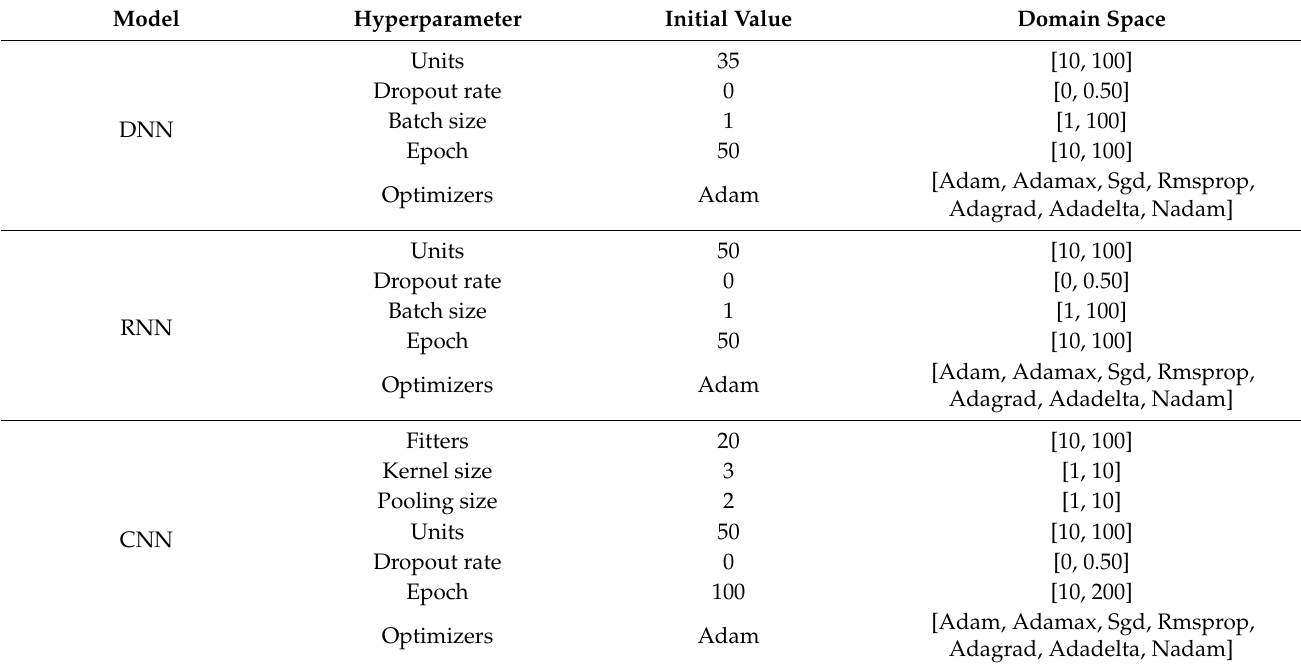
Table 2. Hyperparameters of TPE optimization and their initial values and domain space of DNN, CNN, and RNN